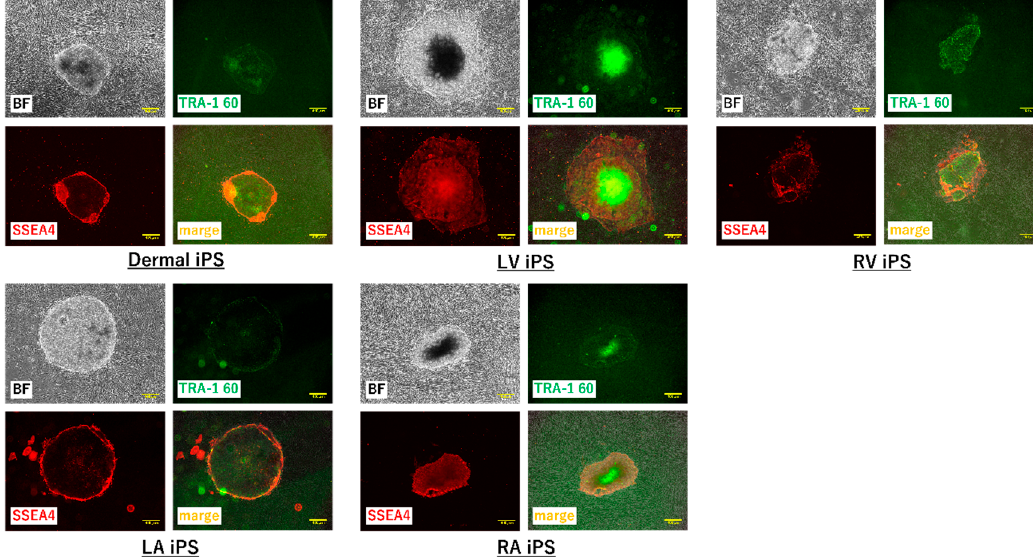
Figure 7. TRA-1-60 and SSEA4 immunofluorescent staining of iPS cell colonies induced from heart transplant recipient myocardial fibroblasts. Bright field (BF; top left), TRA1-60 immunofluorescent staining (top right), SSEA4 immunofluorescent staining (bottom left), and merged (bottom right) images of the iPS cell colonies induced from dermal fibroblasts (dermal) and myocardial fibroblasts from the left atrium (LA), left ventricle (LV), right atrium (RA), and right ventricle (RV) of a heart transplant recipient. Immunofluorescent staining was performed with anti-TRA1-60 antibody and anti-SSEA4 antibody between day 26 and day 35 post-transfection. Scale bars: 400 µm.